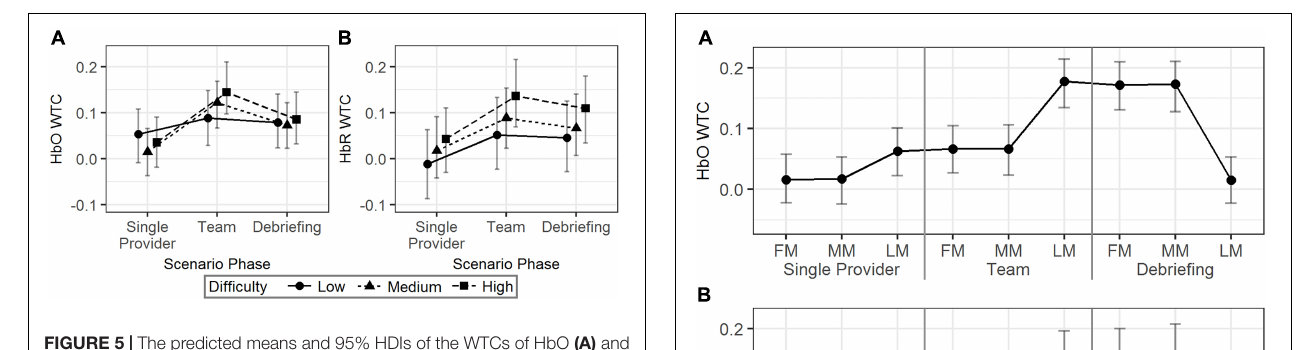
FIGURE 5 | The predicted means and 95% HDIs of the WTCs of HbO (A) and HbR (B) between the initial provider and the responder in a team at different scenario phases. The values of all the other variables were held at their means.